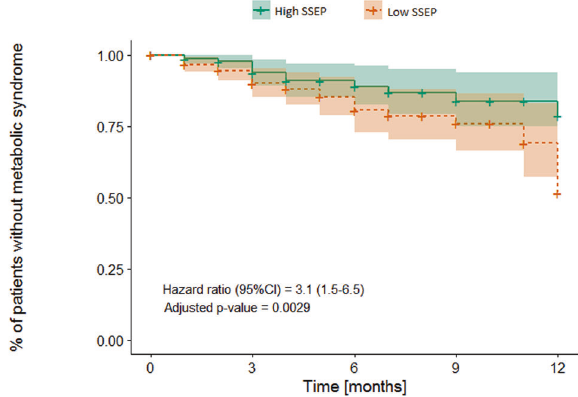
Fig. 1 Incidence of new onset metabolic syndrome according to SSEP over one year of psychotropic treatment in the adult population. Analysis was performed in the adult population (25 ≤ age< 65) and was adjusted by age, sex, fi rst available BMI, diagnosis, risk of psychotropic drug-induced weight gain, using a Cox proportional hazards model ( n = 366). The number at risk at baseline: 168 High SSEP vs 198 Low SSEP, at 3 months: 98 High SSEP vs 109 Low SSEP, at 6 months: 47 High SSEP vs 54 Low SSEP, at 9 months: 29 High SSEP vs 29 Low SSEP, at 12 months: 16 High SSEP vs 16 Low SSEP. High and Low SSEP groups were de fi ned as SSEP over ( ≥ 61.8) vs under (<61.8) median SSEP,